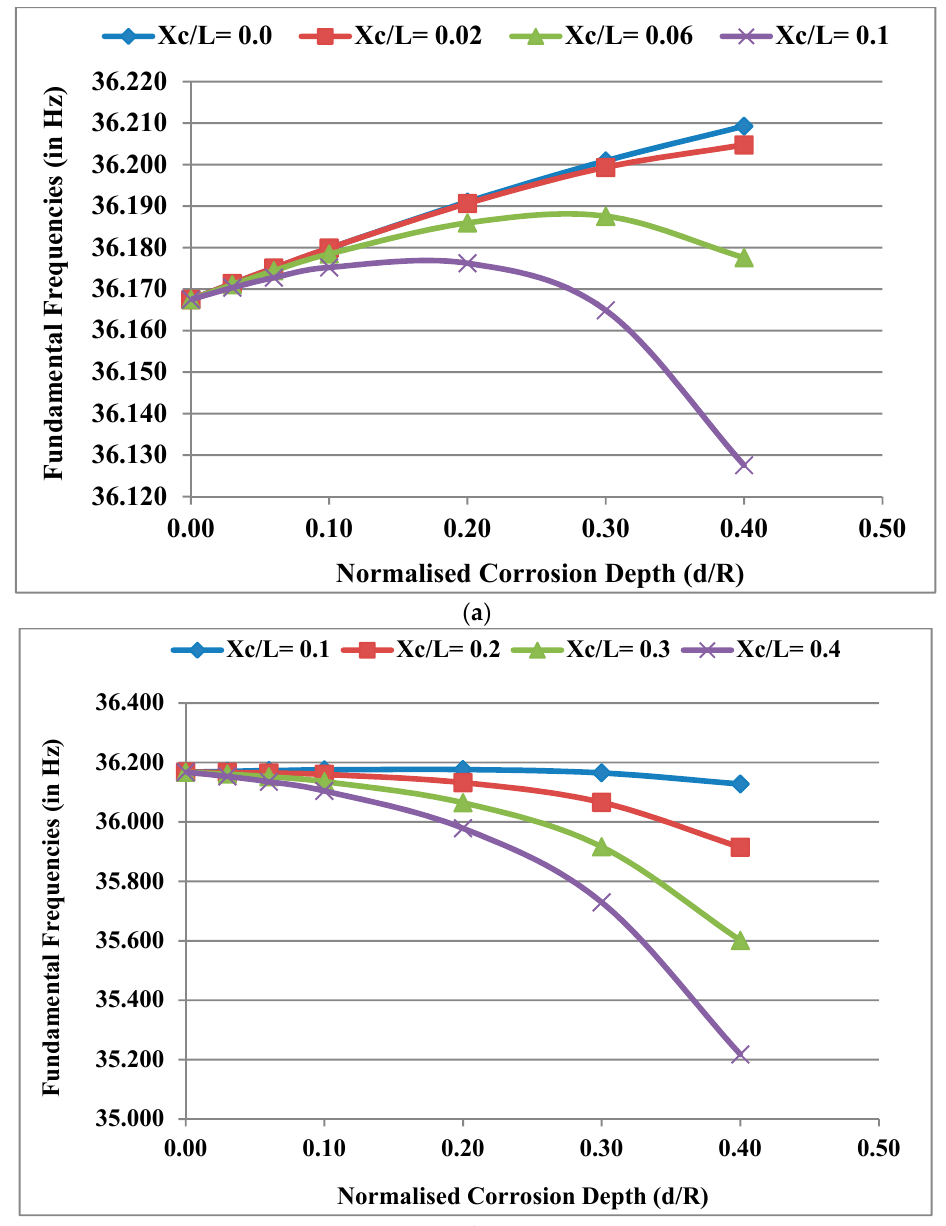
Figure 5. ( a ) Effect of depth (d/R) for different positions (X c /L) ( ≤ 0.1, corrosion located near the bearings) on the fundamental frequencies of the system; ( b ) effect of d/R for different X c /L (0.1 to 0.4), moving away from the bearings and towards the disc on the fundamental frequencies of the system.